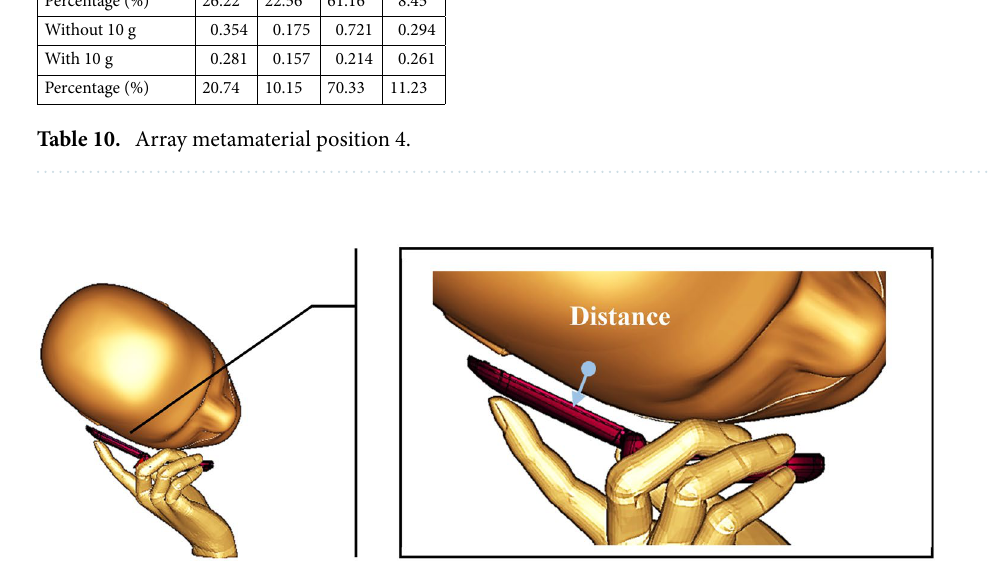
Figure 9. Mobile phone at 5 mm gap from the human head